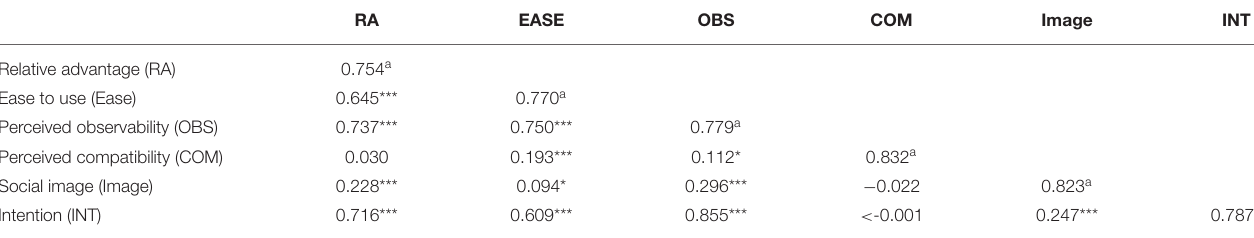
TABLE 4 | Correlation coefficient matrix and square root of average variance extracted of latent variables.